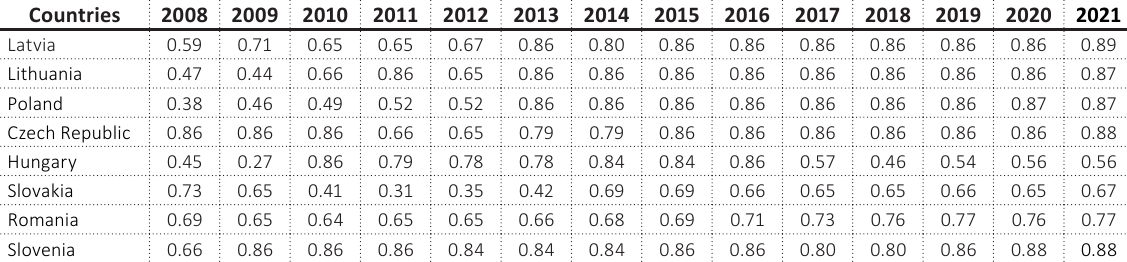
Table 2. Dynamics of the integral indicator of macro-financial stability in EU countries